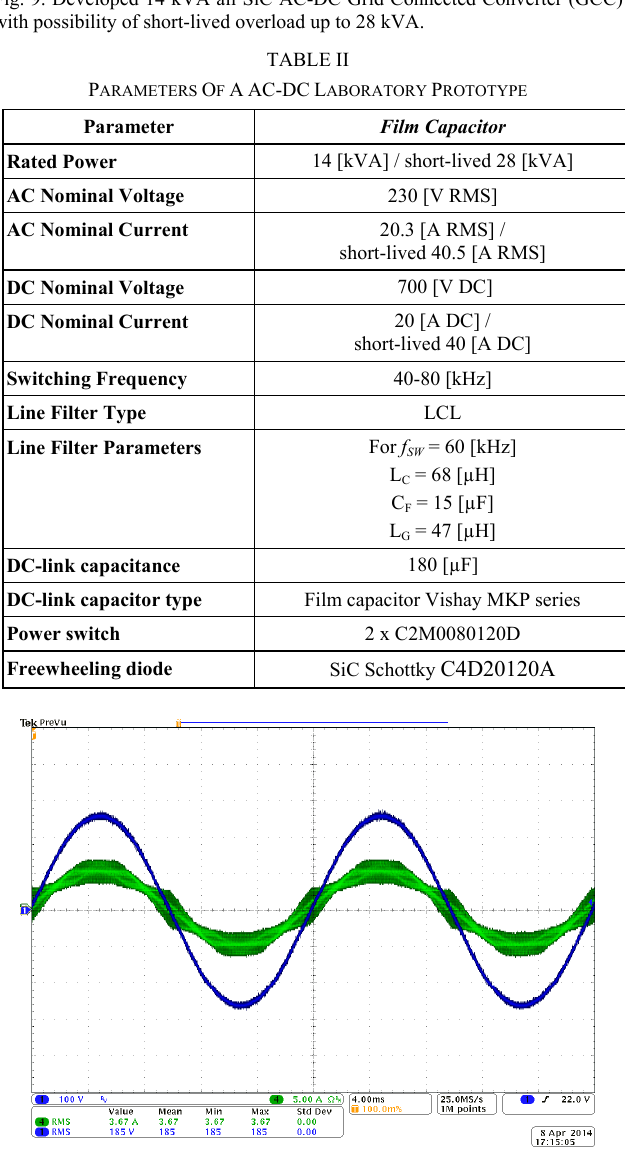
Fig. 10. Start-up of the prototype all SiC AC-DC converter. Current (green) and voltage (blue) waveforms of one phase. Islanding operation (resistive load) with 550 [V] in DC-link, f SW =40